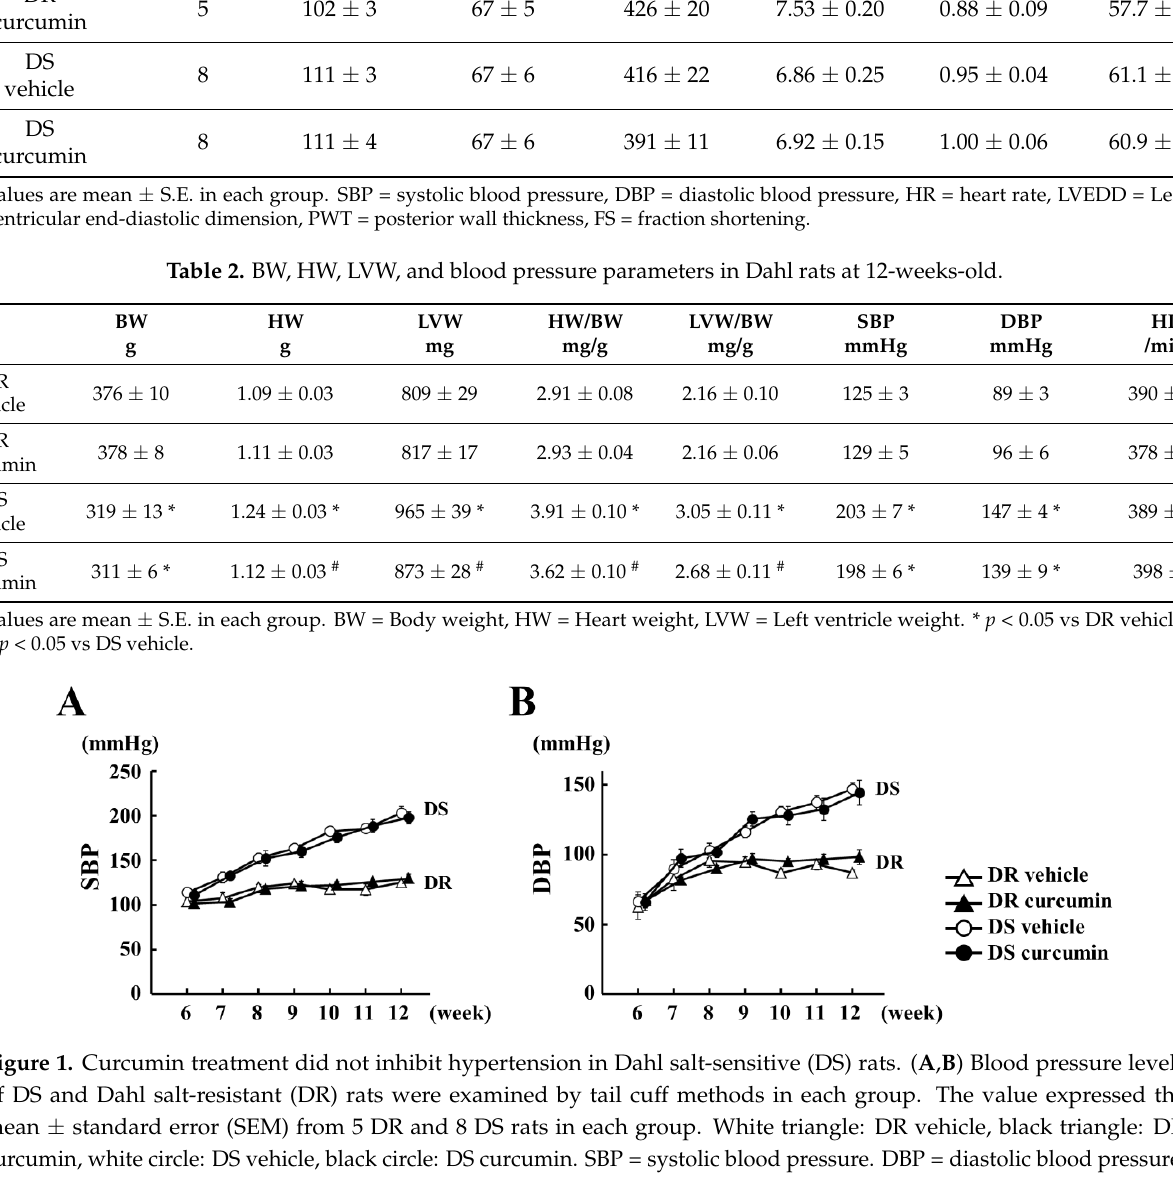
Values are mean ± S.E. in each group. SBP = systolic blood pressure, DBP = diastolic blood pressure, HR = heart rate, LVEDD = Left ventricular end-diastolic dimension, PWT = posterior wall thickness, FS = fraction shortening. Table 2. BW, HW, LVW, and blood pressure parameters in Dahl rats at 12-weeks-old .